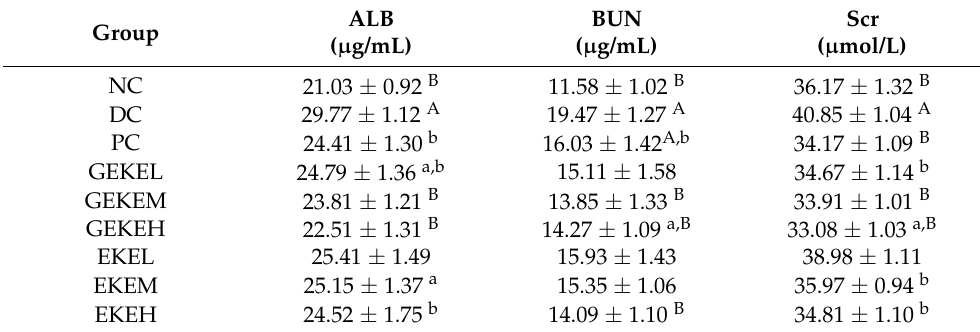
Table 7. Renal function index in each group of mice (x ± s, n = 10). ALB Group ( µ g/mL)